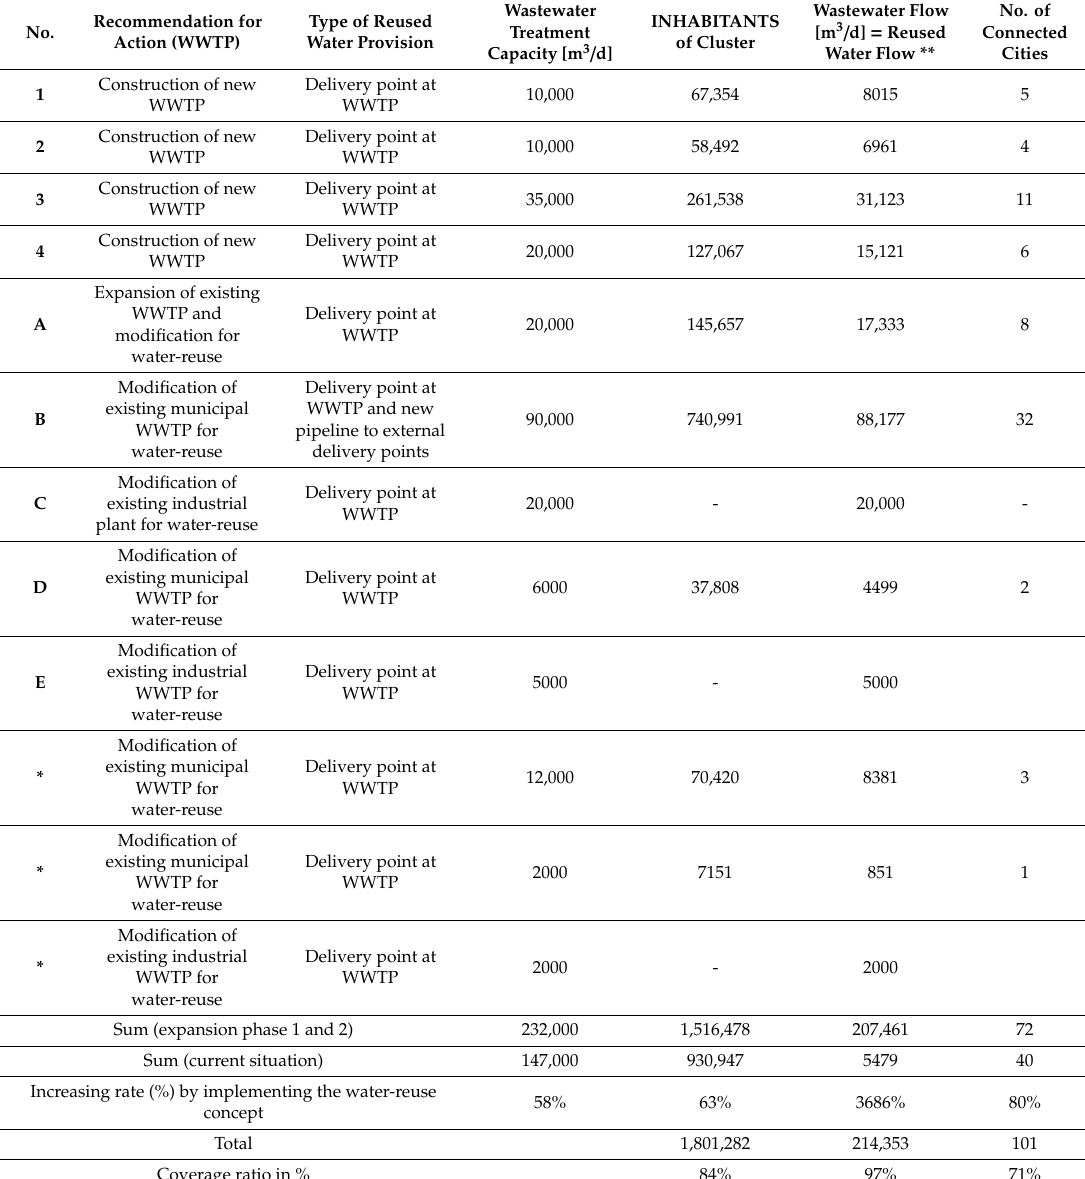
Table 4. Increasing reused water availability by implementing further wastewater treatment options.